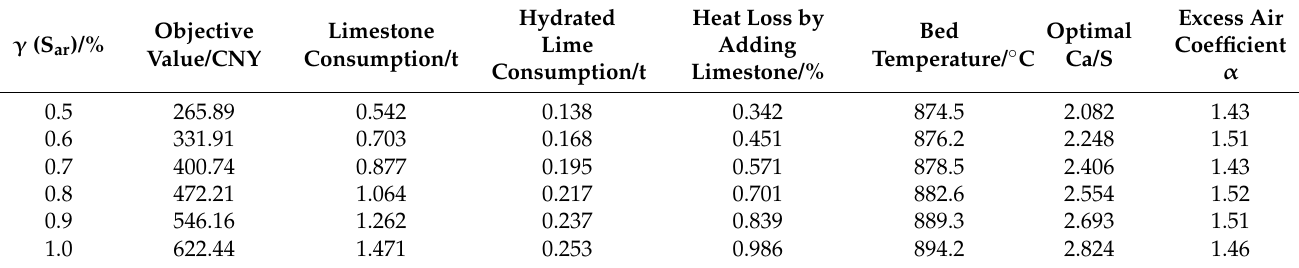
Table 3. The effect of adding limestone on the heat loss of the boiler of the desulfurization system. Objective γ (S ar )/%